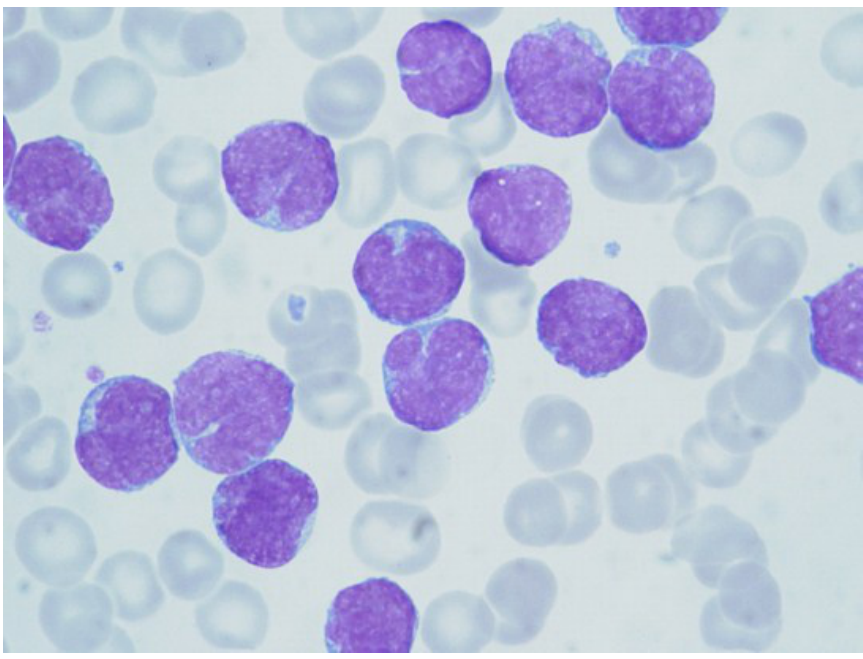
FIGURE 1. Peripheral blood smear. A population of mantle cells with cleaved nucleus and paucity of cytoplasma (May-Grünwald-Giemsa staining, original magnification  1160). The majority of cells in the figure appear cleaved, showing an unusual variant of